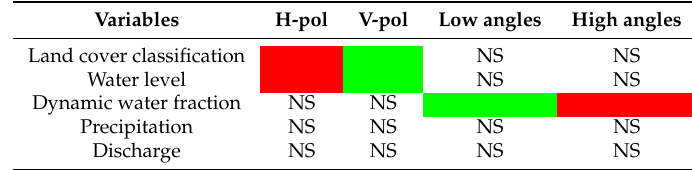
Table 5. Summary of the best SMOS configurations permitting a good agreement between SWAF and the other variables. Green color means that good agreement was found, whereas the red color means the opposite. See Section 5 for the results. NS,